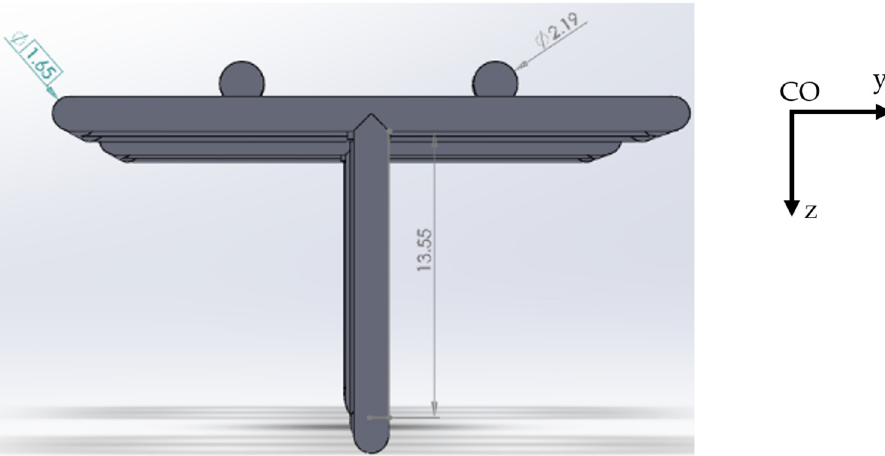
Figure 5. Front view of the model (dimensions in cm) (developed with SolidWorks [60]).